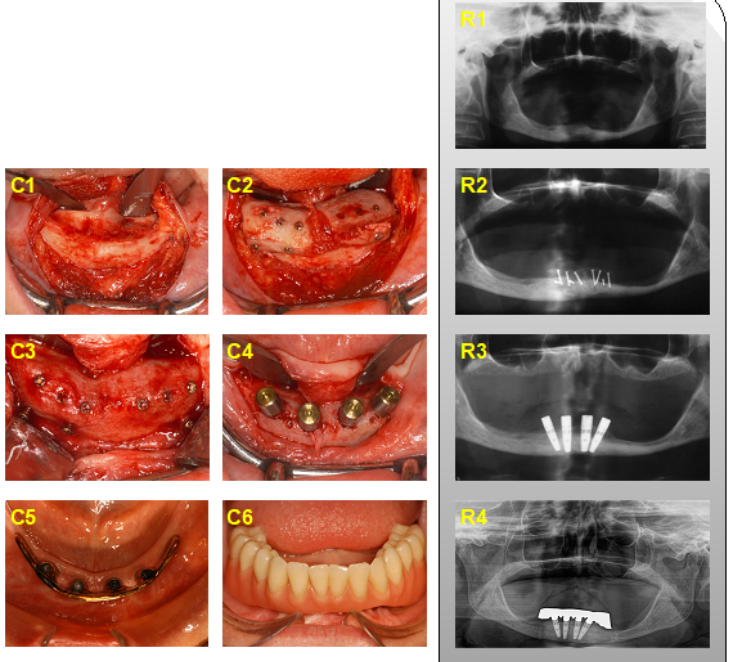
Figure 1. Clinical ( C1 – C6 ) and radiographic ( R1 – R4 ) presentation of iliac crest bone augmentation